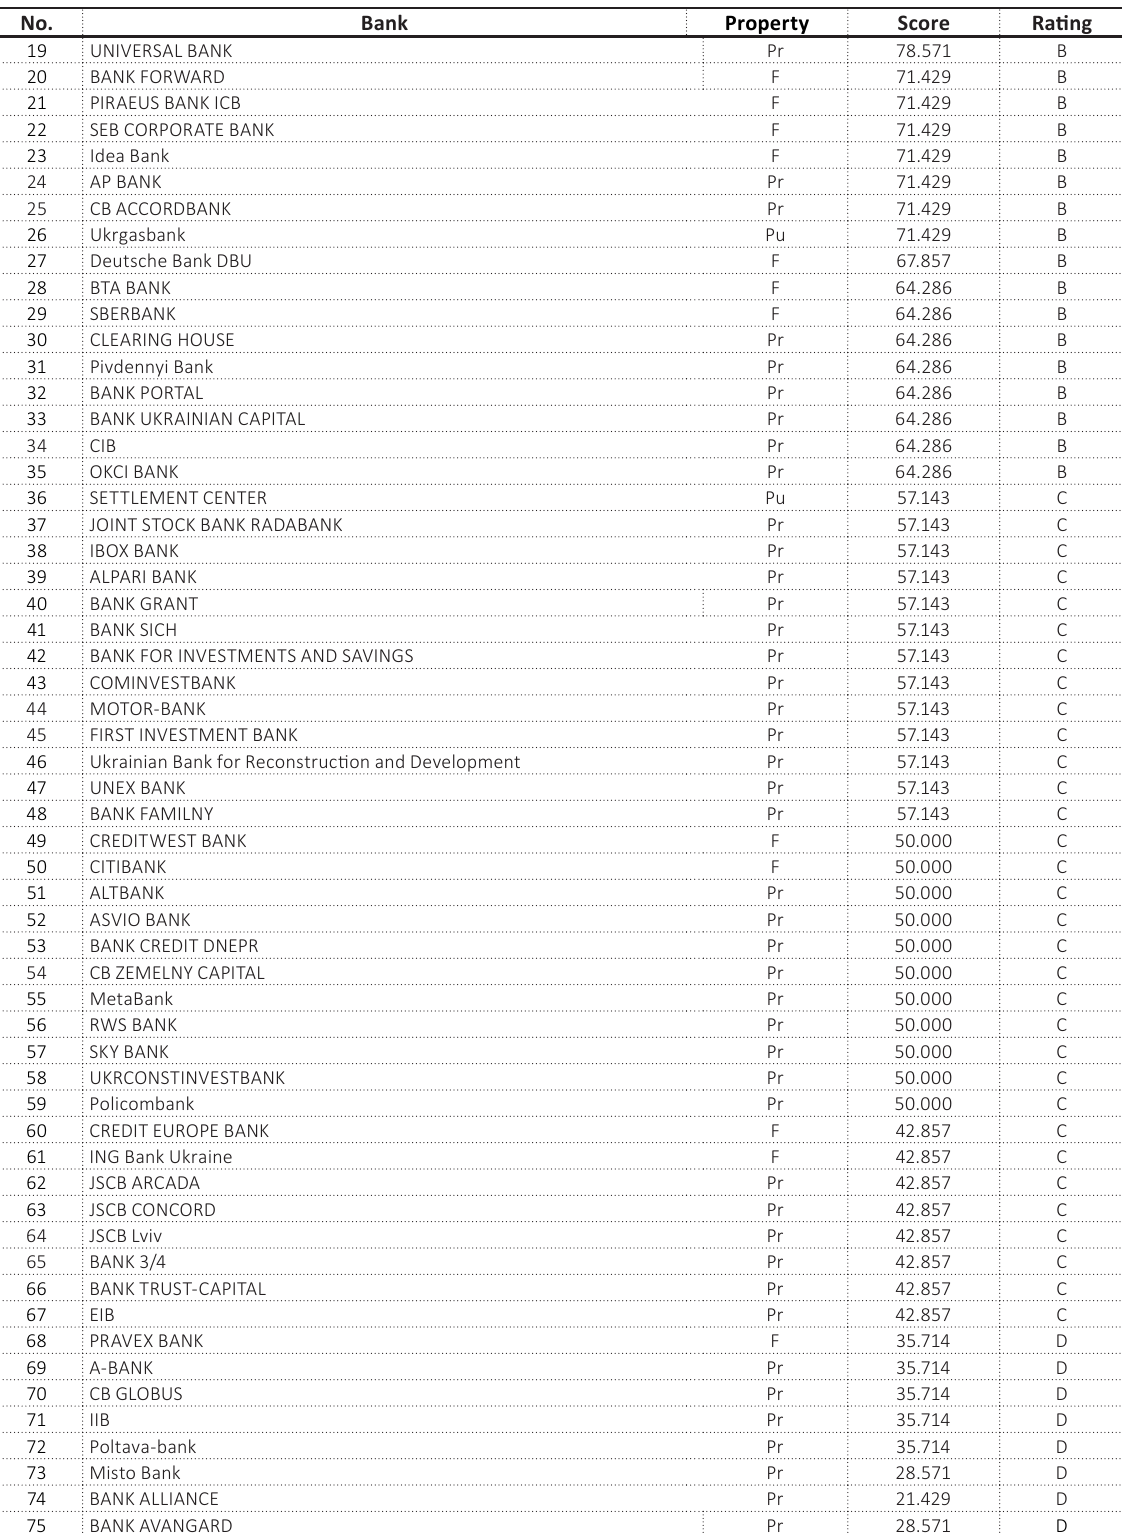
Table A1 (cont.). Q&C BMR index and bank rating in